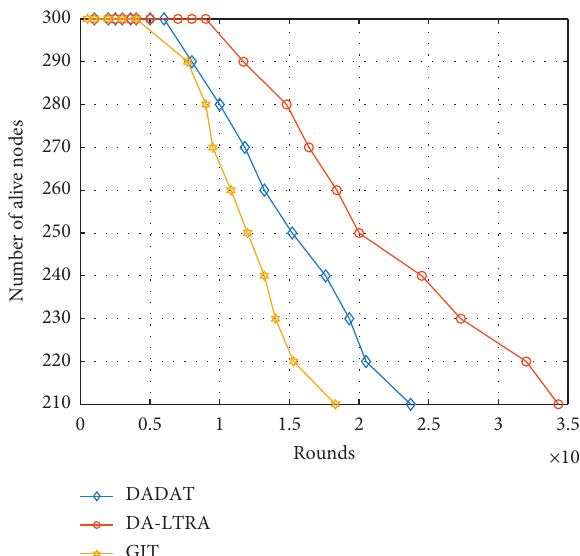
Figure 8: Lifetime comparison under different rounds.